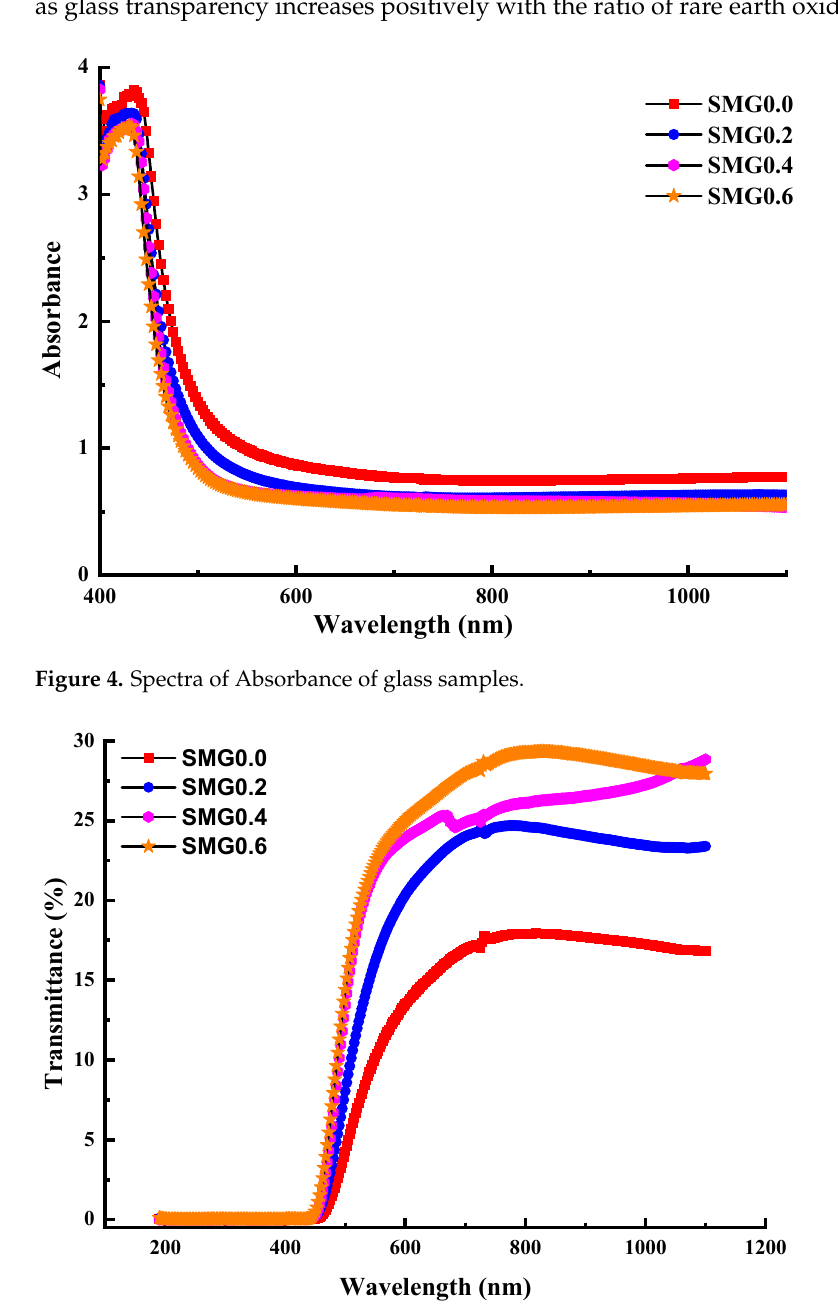
Figure 5. Spectra of transmittance of glass samples. The absorption coefficient α of the proposed glass system samples, depending on the absorbance values (A), is calculated with the help of the following equation [27]: A α = 2.303 (1) t In Equation (1), t shows the film thickness. The modification of the absorption coef- ficient ( α ) with incident photon energy (hv) for glass samples in the (Tl 2 O 3 ) 30 -(Li 2 O) 10 - (B 2 O 3 ) (60 − y ) -(Sm 2 O 3 ) y system is depicted in Figure 6. As the content of Samarium (III) oxide in the solution increases, α value decreases, and the edges become extremely